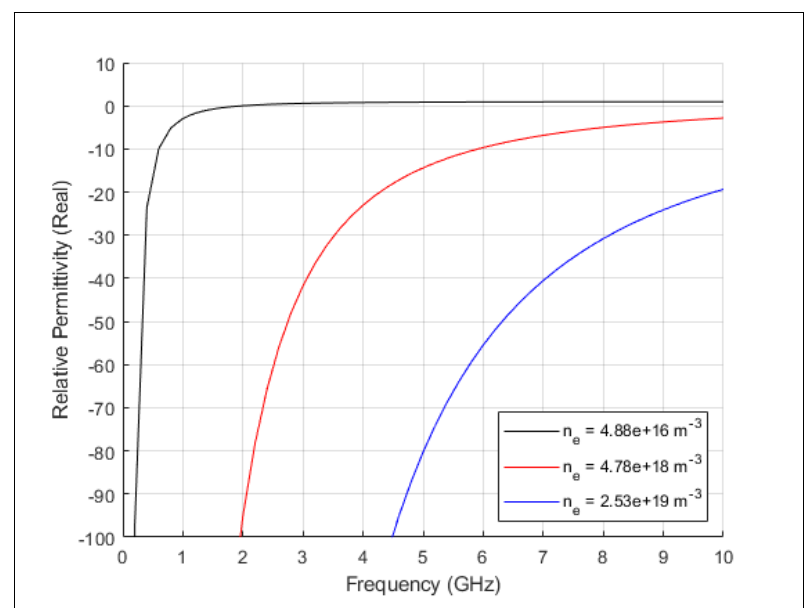
Figure 3. Real part of the relative permittivity versus the source frequency and the electron density of the